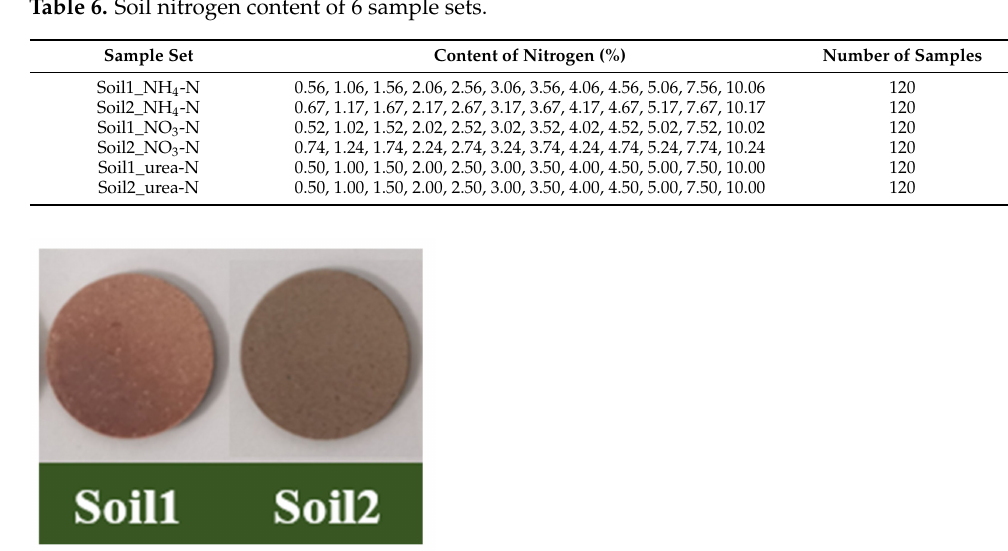
Figure 5. The RGB image of soil samples after